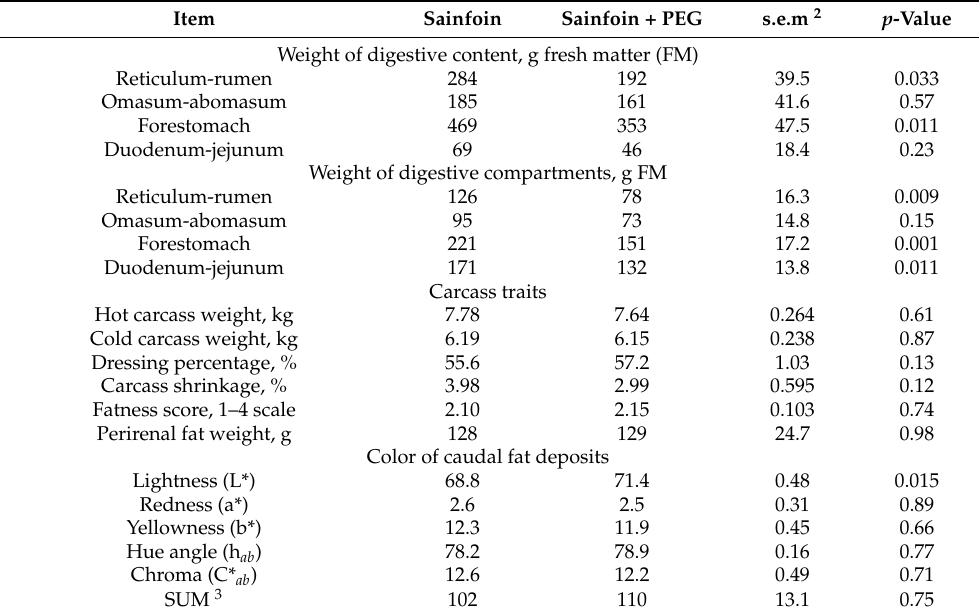
Table 2. Effect of the presence of proanthocyanidins (PAC) in the dams’ diet 1 on the weights of the digestive compartments, the carcass characteristics and the color of caudal fat deposits of their suckling lambs.